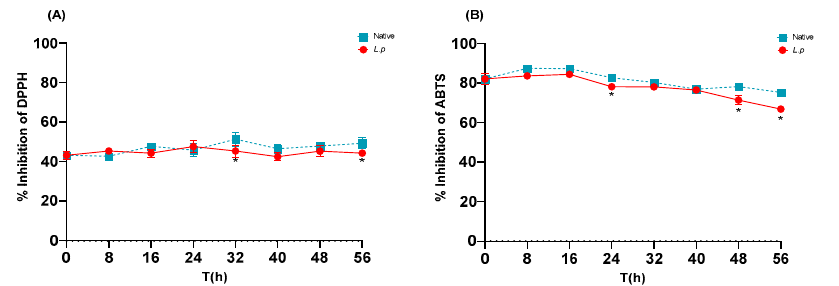
Figure 5. Temporal course of inhibition of DPPH ( A ) and ABTS ( B ) radicals during native and controlled fermentation ( Lp ) of the C. ficifolia juice for 56 h. * Significant difference ( p < 0.05) concerning unfermented juice (t = 0). T-paired test (Mean ± S.D., n = 3). Tukey’s post-hoc test.